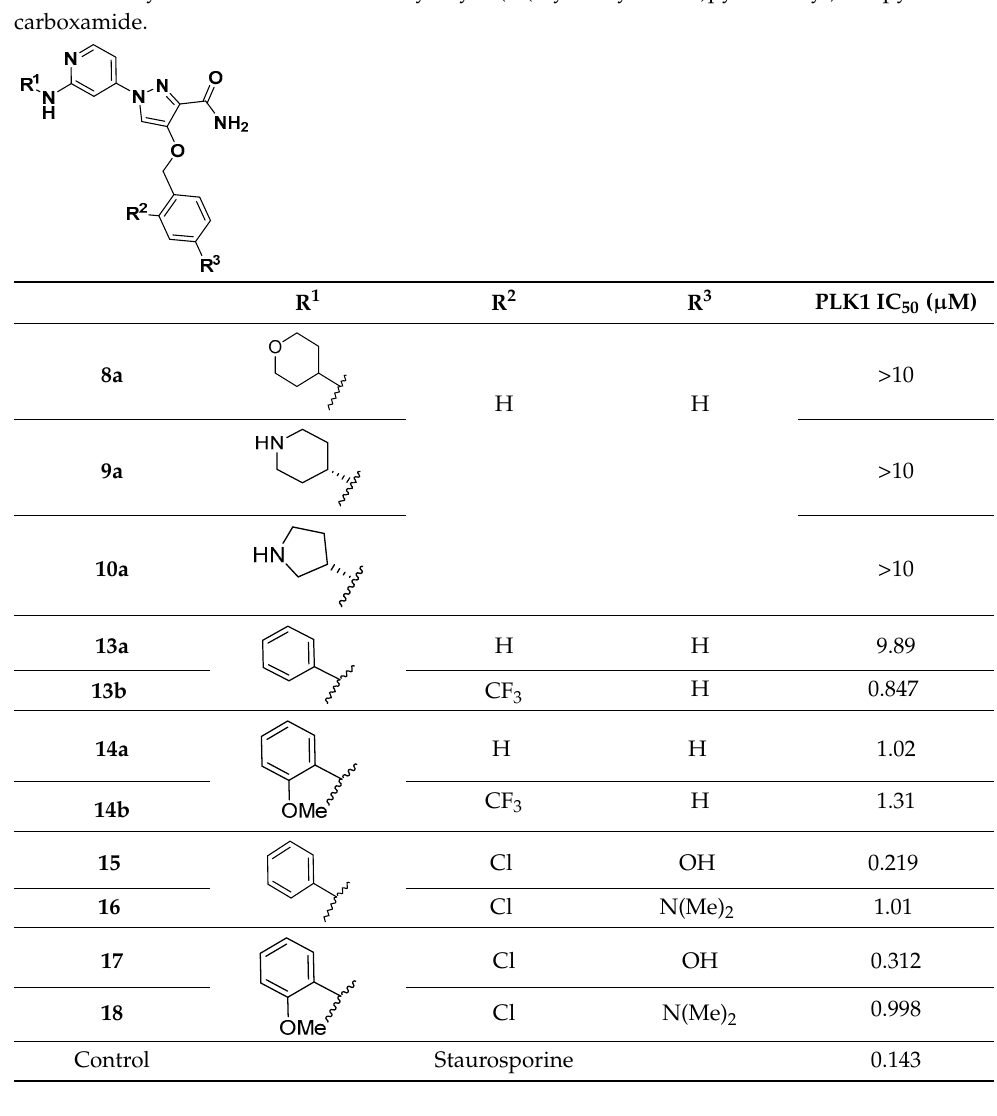
Table 2. Enzymatic activities of 4-benzyloxy-1-(2-(aryl/alkylamino)pyridin-4-yl)-1 H -pyrazole-3- carboxamide.